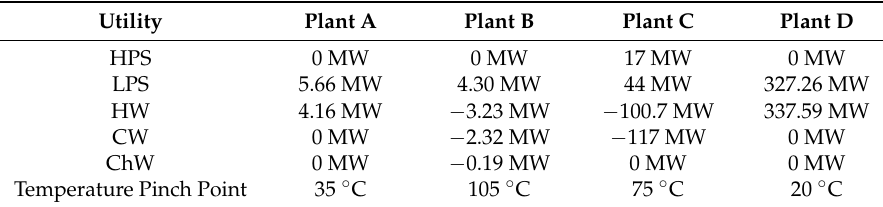
Table 7. Summary of MU PTA for Industrial Plants A to